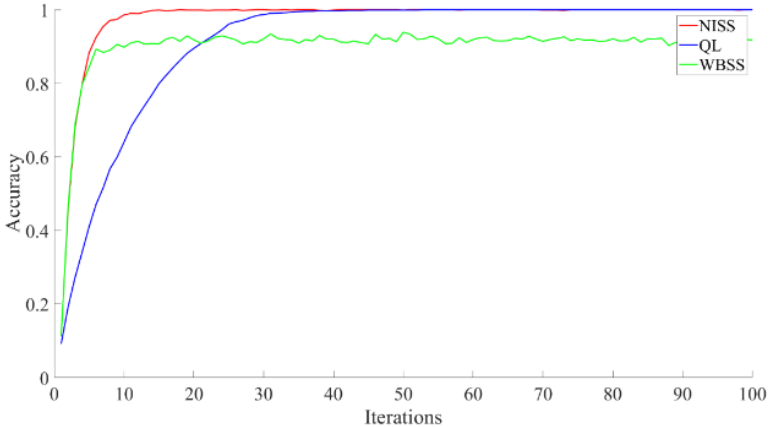
Figure 7. Decision accuracy of three anti-linear sweep jamming algorithms. Since the actual jamming cannot be such regular linear sweep jamming, to verify the applicability of the algorithm under complex jamming patterns, the simulation verification against intelligent blocking jamming is carried out, and the results are shown in Figure 8.